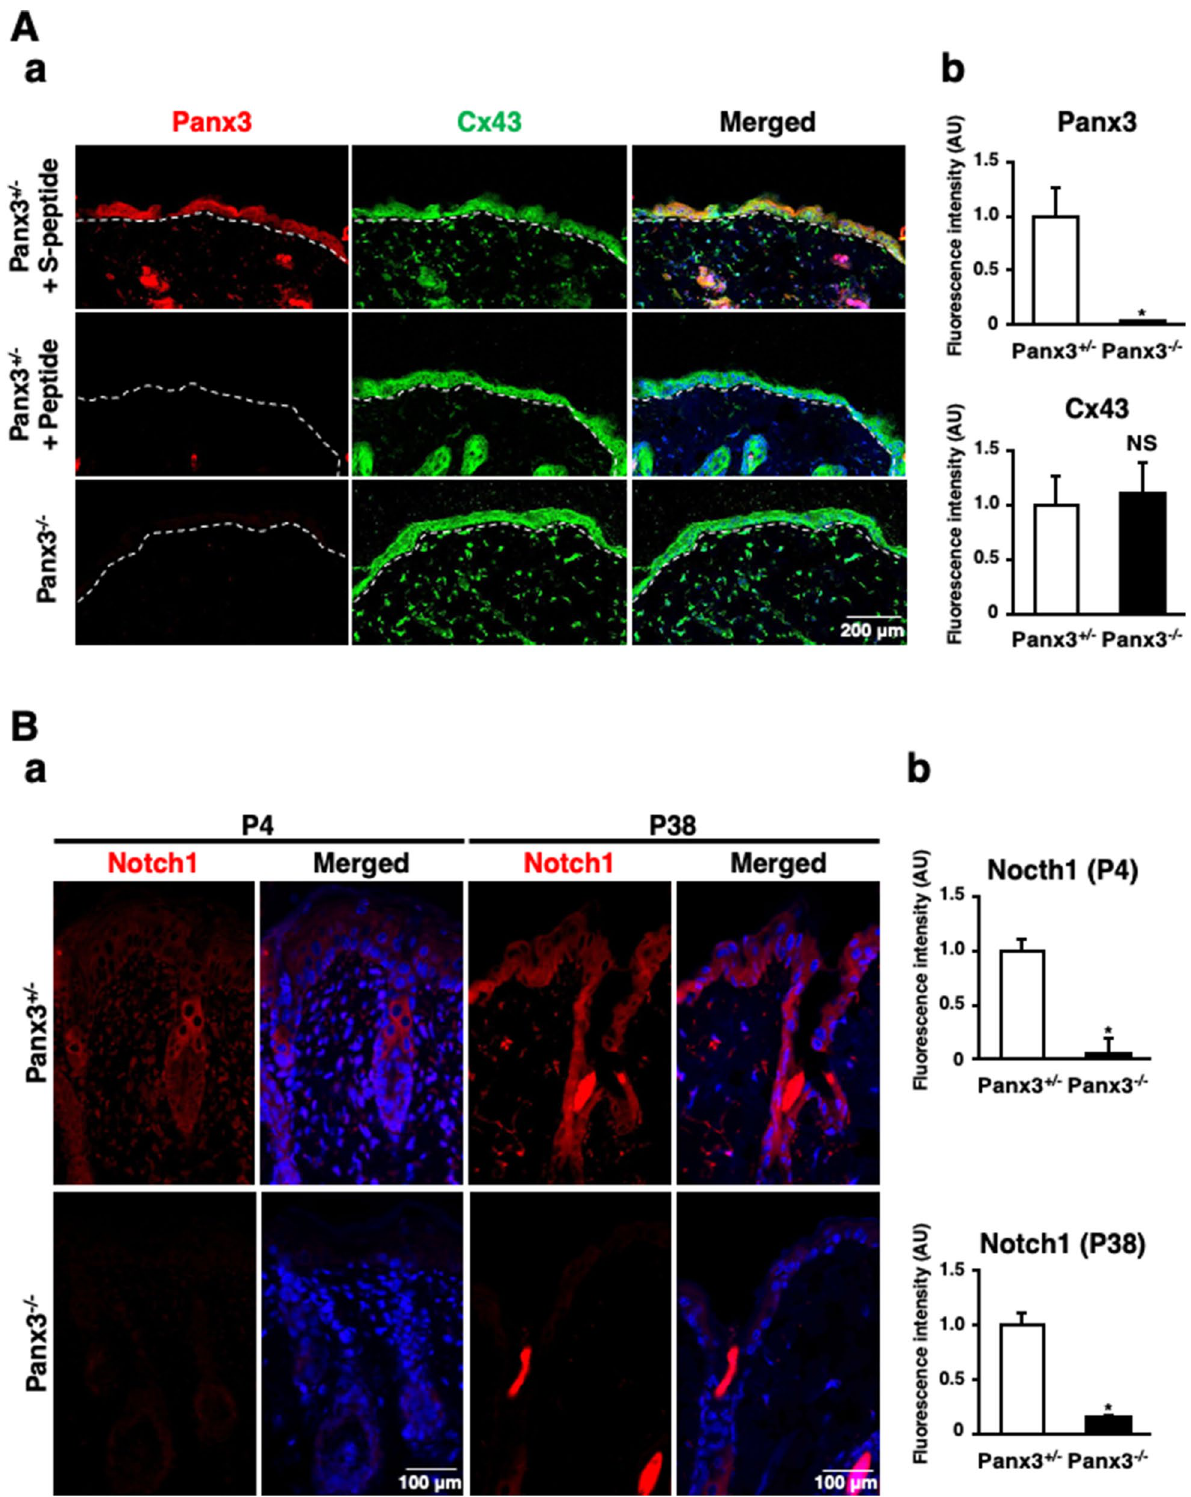
Figure 2. Panx3 deficiency inhibits keratinocyte differentiation. ( A ) Immunostaining of skin of 6 weeks old Panx3 +/− (top and middle) and Panx3 −/− (bottom) mice for to Panx3 (red) and Cx43 (green) in the presence (top and middle) or absence (bottom) of Panx3 cognate peptide (middle) or control peptide (S-peptide) (top) ( a ). Dotted lines indicate borders between epidermis and dermis. ( B ) Immunostaining of skin of Panx3 +/− and Panx3 −/− mice on P4 and P38 with antibody to Notch1(red). The nuclei were counterstained with DAPI (blue in merged) ( a ). Relative fluorescence intensity comparison of images were analyzed (M&M) ( A , b and B , b ). * p < 0.01. Error bars represent the mean ± SD; N =